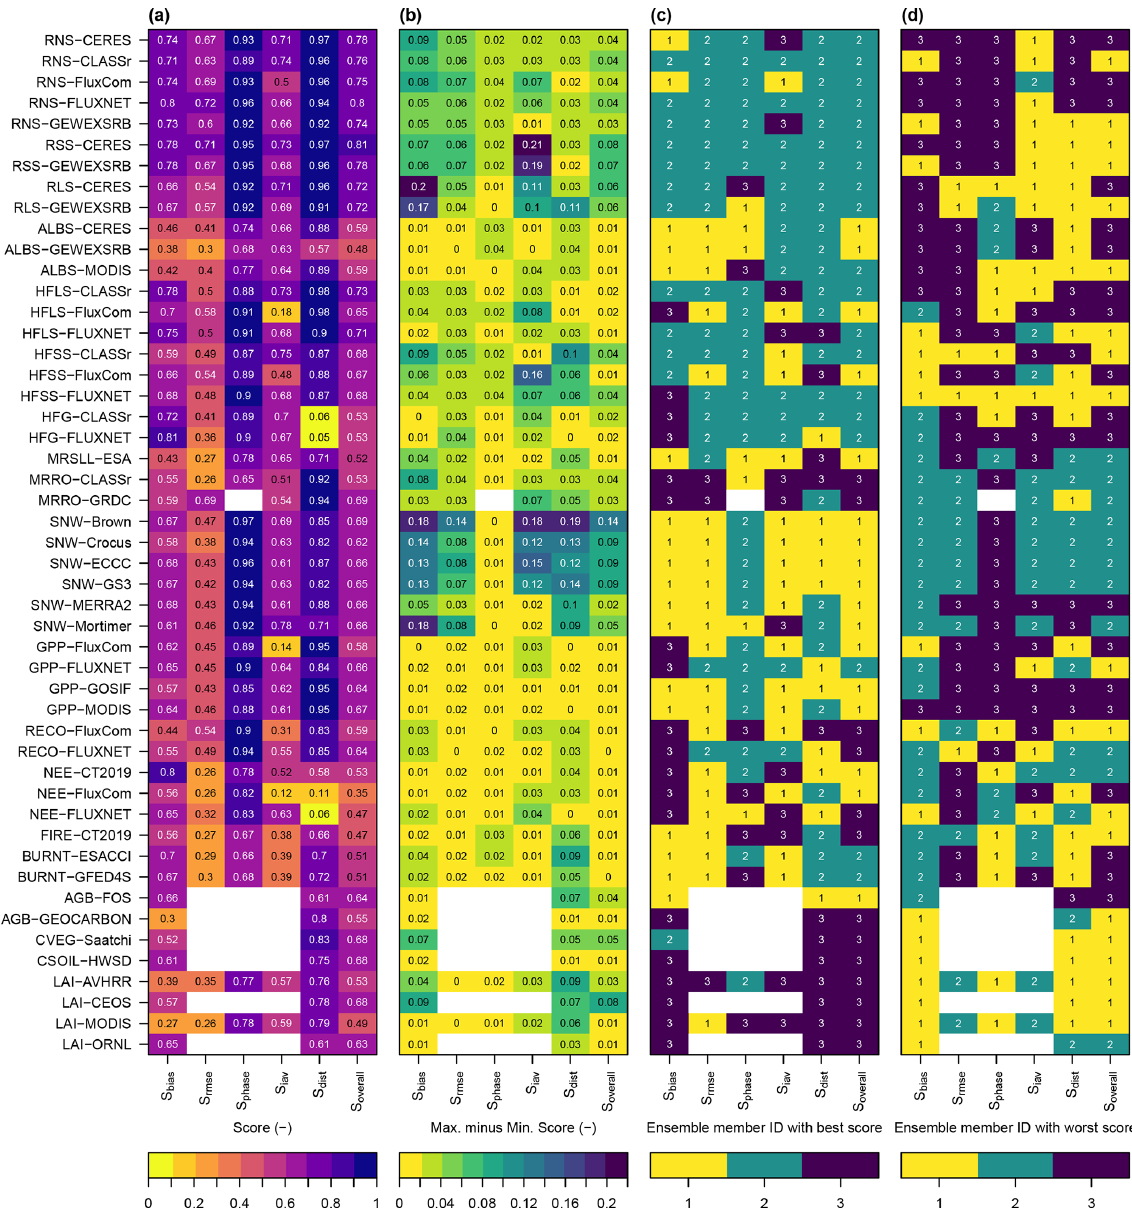
Figure 9. (a) Mean ensemble score, (b) maximum score difference among ensemble members, and ensemble member with the (c) highest and (d) lowest score. Ensemble member IDs refer to model runs conducted with data from (1) CRUJRAv2, (2) GSWP3W5E5, and (3)